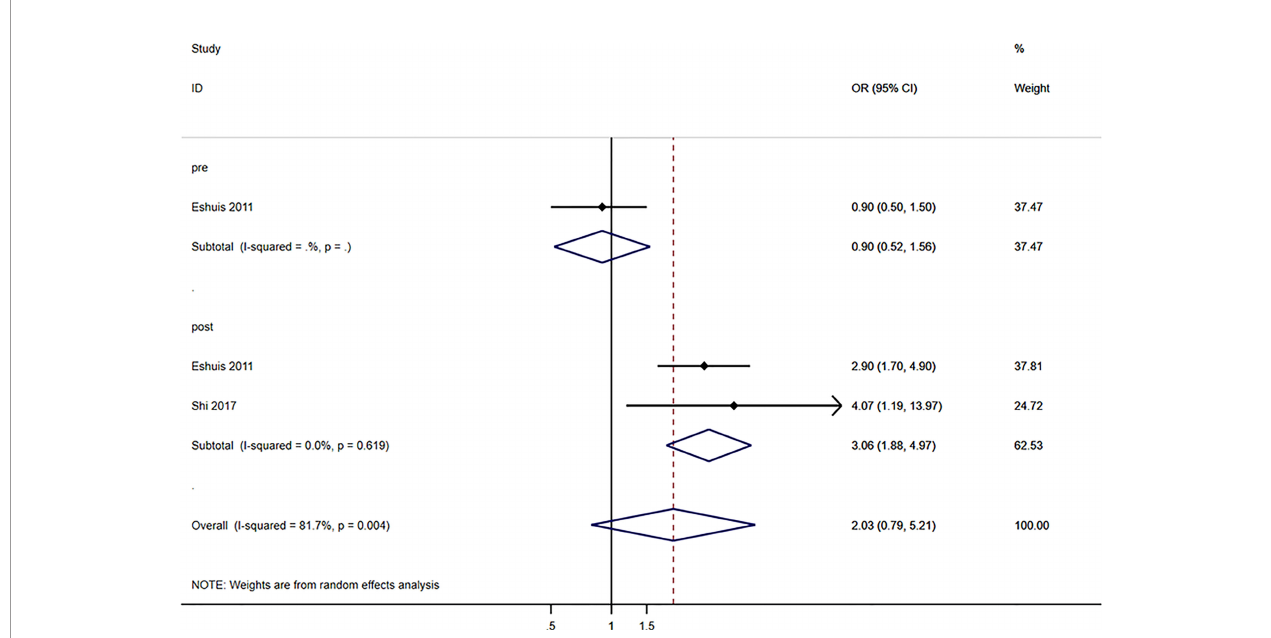
FIGURE 4 | The prognostic role of the blood glucose values in postoperative complications.